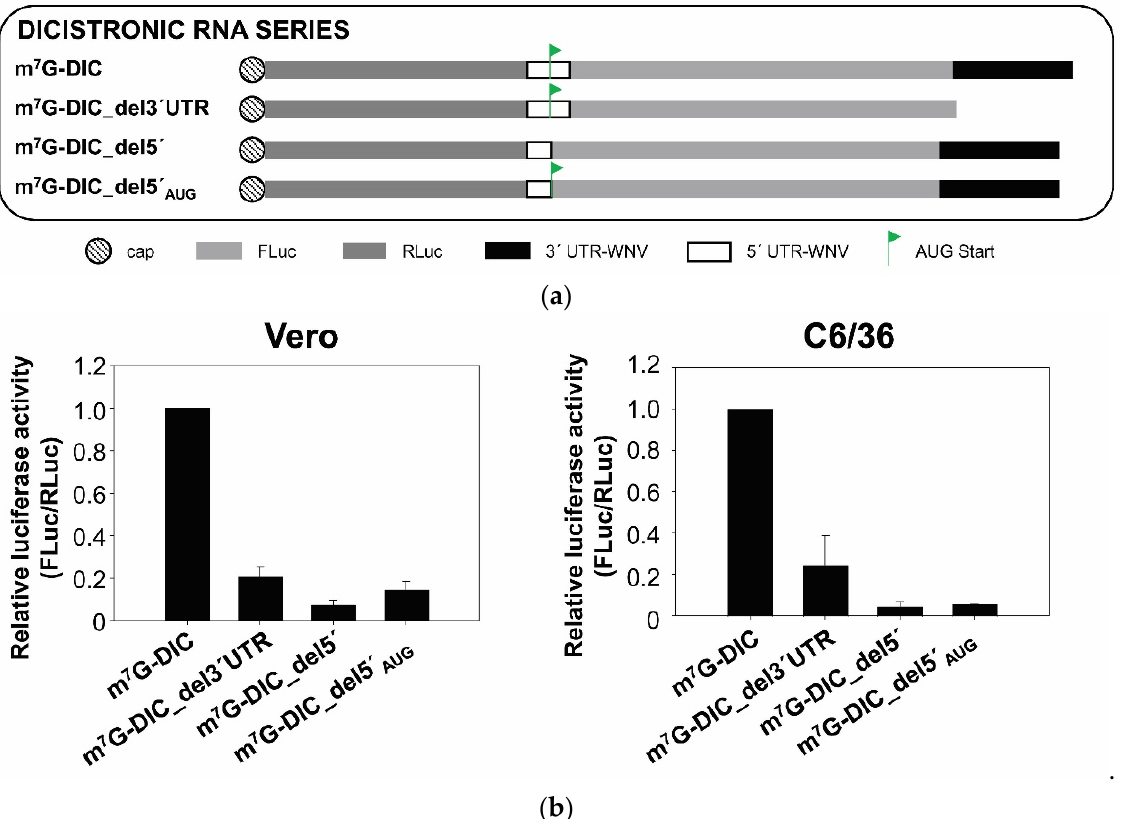
Figure 2. The 5 ′ end of the WNV genome promotes the internal initiation of translation. ( a ) Diagram of the dicistronic RNA constructs harbouring the capped RLuc mRNA at the 5 ′ end of the FLuc coding sequence flanked by the 5 ′ end, or truncated variants (del and del AUG , respectively) and the 3 (cid:48) UTR of the WNV RNA genome. ( b ) Translation efficiency of dicistronic RNA constructs. Vero and C6/36 cells were transfected with an RNA construct indicated in ( a ); left and right panels respectively). Translation activity was determined as the FLuc protein activity and normalised against the value obtained for RLuc. Values refer to that of the dicistronic RNA containing the 5 (cid:48) end (nt 1–160) of the WNV m 7 G-DIC